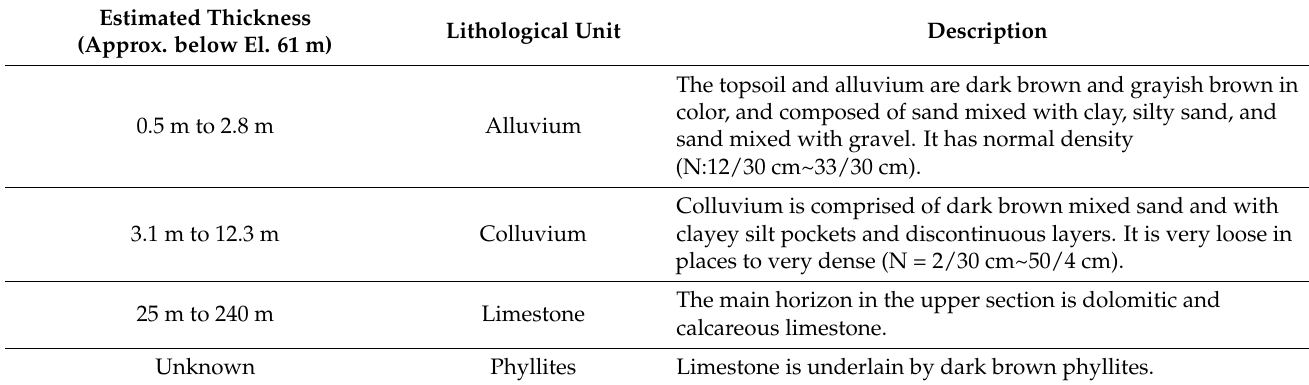
Table 3. Summary of lithological data obtained from the investigation boreholes.